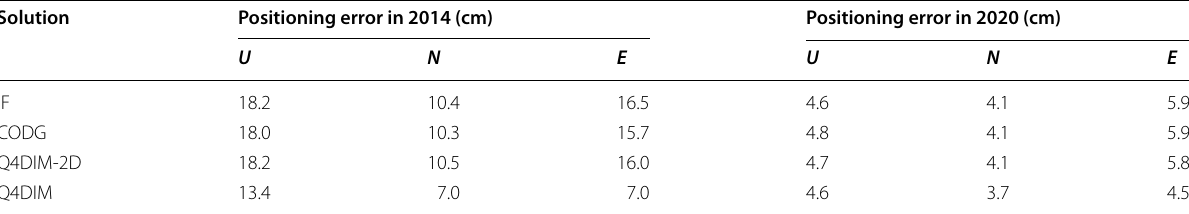
Table 5 DF‑PPP positioning error of RMS in Up( U ) / North( N ) / East ( E ) in 2014 and 2020 Solution Positioning error in 2014 (cm) Positioning error in 2020